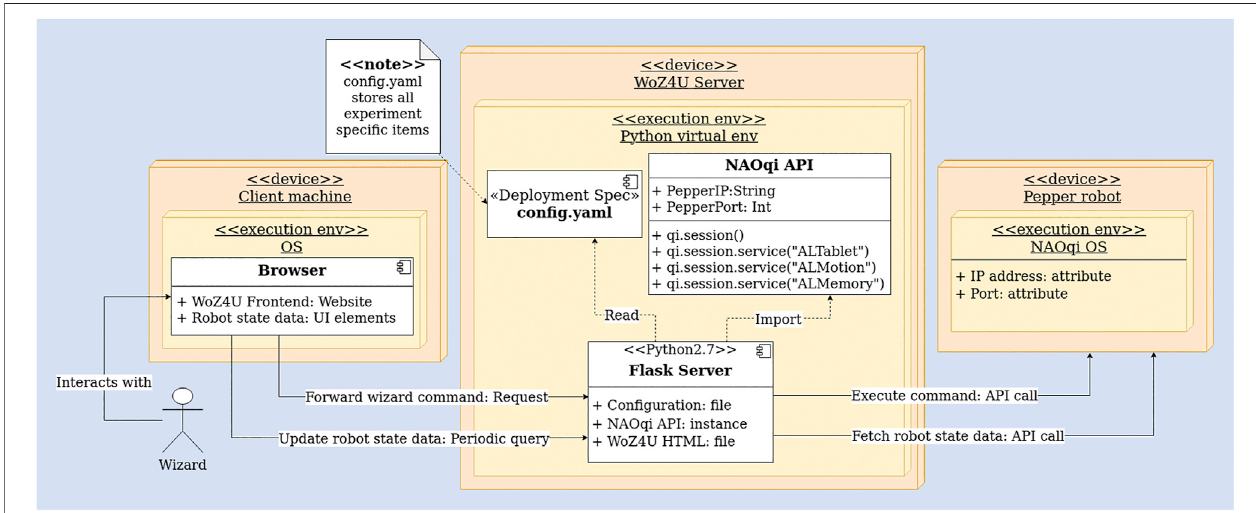
FIGURE2| Thecomplete WoZ4Usystem intheformofanextended deploymentUMLdiagram showing theconnectedand interactingcomponents,startingwith the wizard ’ s input, and leading to the execution of a command on the robot. The WoZ4U server component maps requests from the frontend to robot API calls and keeps the frontend up-to-date by continuously fetching data from the robot. The frontend is populated with experiment-speci fi c UI elements de fi ned in the con fi guration fi le.